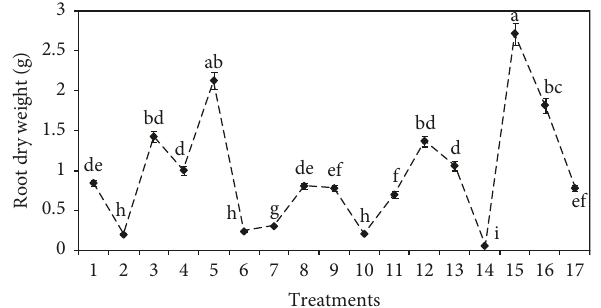
Figure 9: Impact of biosorbed water by various biosorbents (or- ange peels, pomegranate peels, and peanut peels) on root dry weight of mung bean after 7 days of seed germination. T1, negative control; T2, 50mg kg − 1 ; T3, pomegranate peel biosorbed water +50mg kg − 1 ; T4, peanut peel biosorbed water +50mg kg − 1 ; T5,